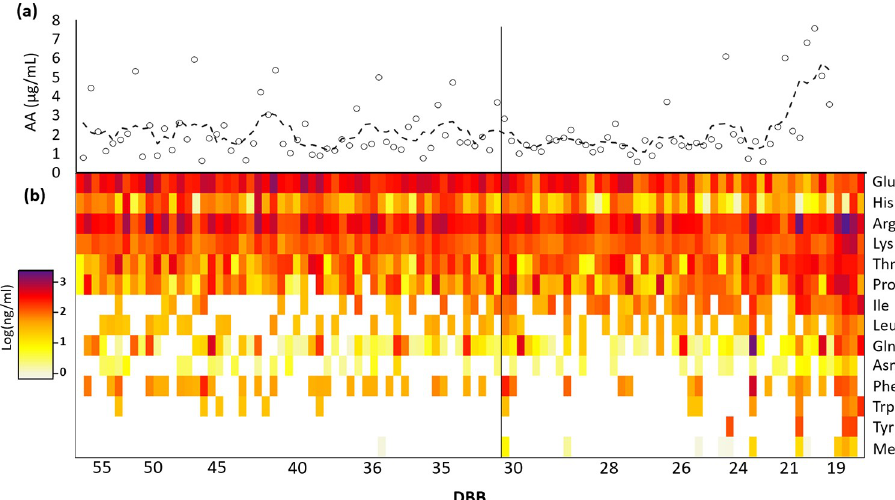
Fig 7. Heat map of target amino acids showing their (a) combined concentrations in μ g/ml and (b) individual contributions. Glutamic acid and Histidine showed an overall decrease across the season, whereas the other amino acids showed a degree of increase. Methionine, tyrosine and tryptophan were only rarely detected in early season sap, however were detected frequently near the end of the season.